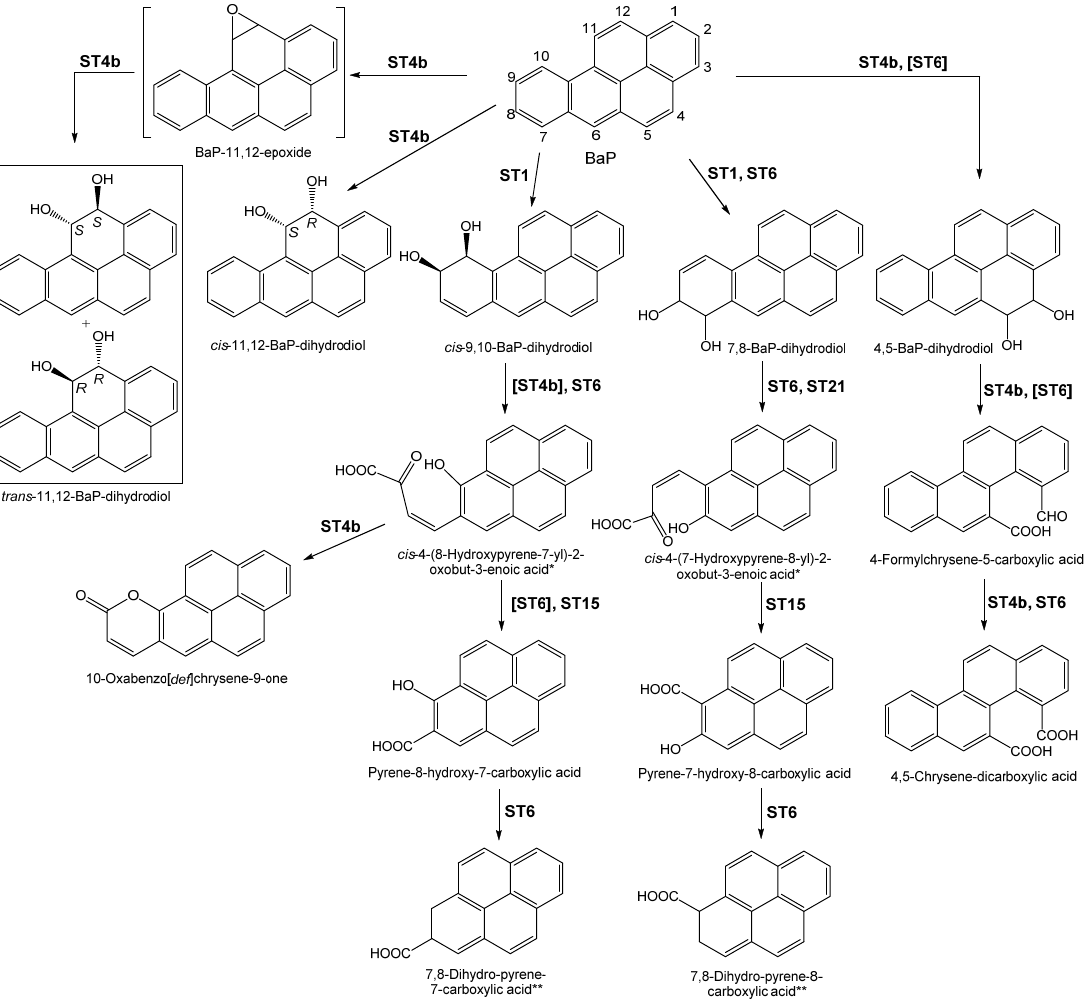
enantiomers in the box were formed in equal ratio. Strains in brackets indicate that the step was predicted, thus was hypothetical. Otherwise, except the structures in brackets, all compounds were identified in the afore-mentioned studies.